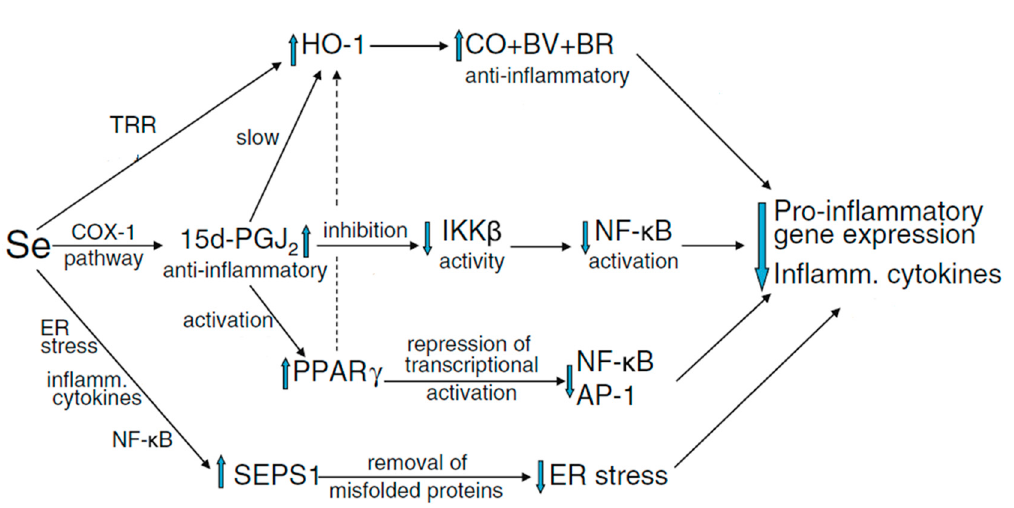
Figure 1. Possible mechanisms by which Se may reduce inflammation resulting from oxidative and ER stress. Abbreviations: ER, endoplasmic reticulum; SEPS1, selenoprotein S; 15d-PGJ2, 15-deoxy- ∆ 12,14-prostaglandin J2; IKK β , I κ B-kinase β ; TRR, thioredoxin reductase; BV, billiverdin; BR, billirubin; PPAR- γ , peroxisome proliferator-activated nuclear receptor- γ (adopted by permission from [29] , Springer Nature, New York, USA).